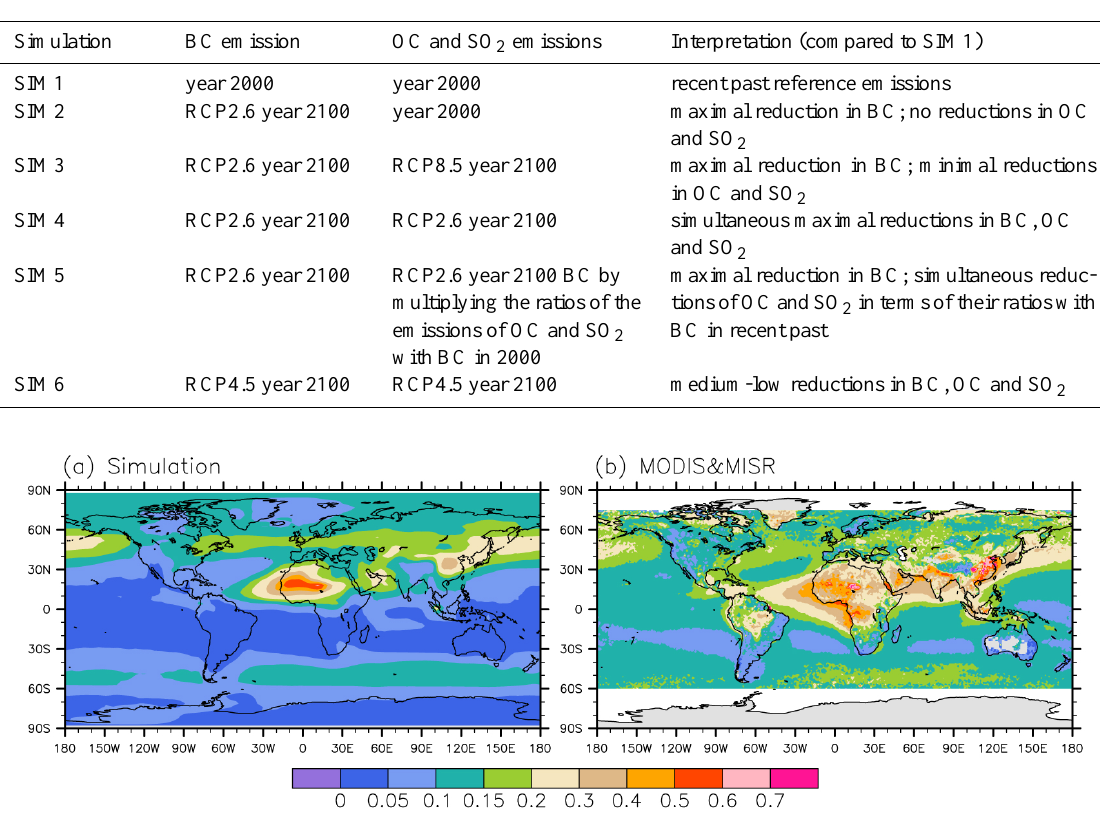
Figure 1. Global distributions of simulated and observed annual mean aerosol optical depth (AOD) at 550nm. (a) Simulation and (b) MODIS&MISR (van Donkelaar et al.,